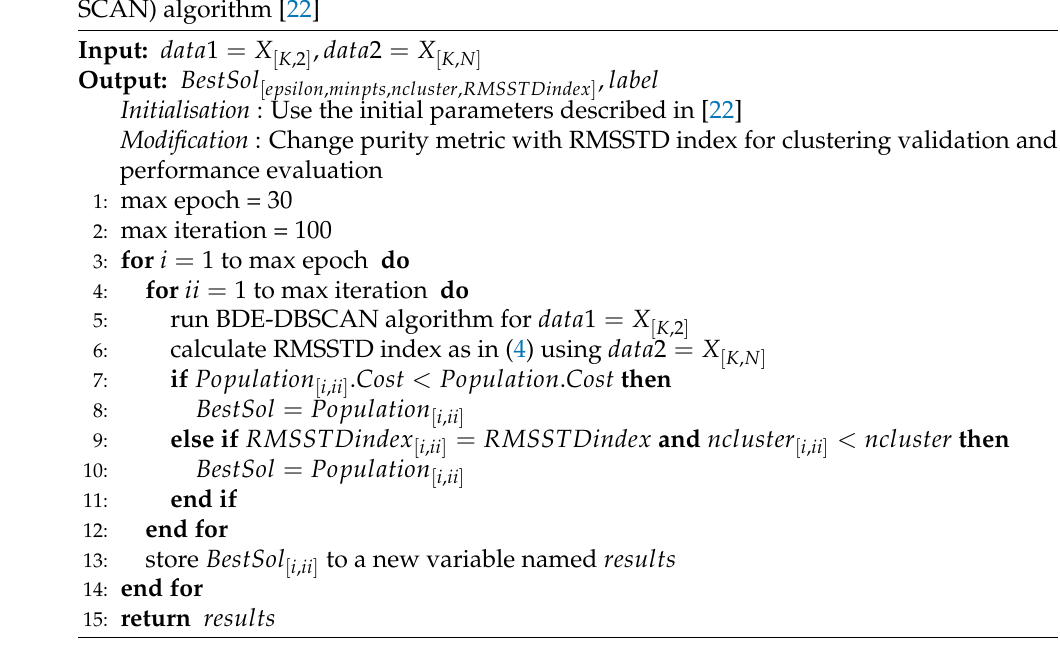
Algorithm 1 Pseudo-code of the proposed outlier detection process based on the binary differential evolution (BDE)–density-based spatial clustering applications with noise (DB- SCAN) algorithm